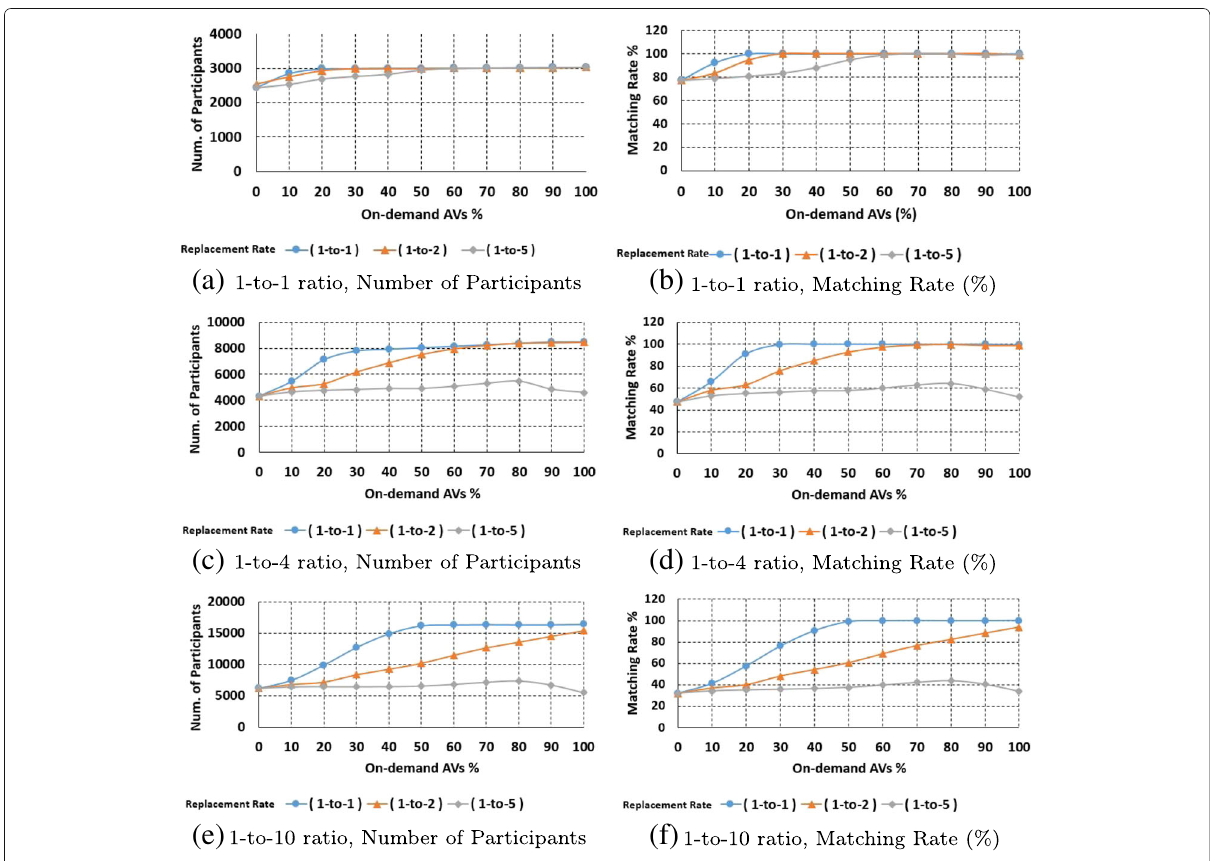
Fig. 10 Paris - Different owner-to-rider ratios. a 1-to-1 ratio, Number of Participants b 1-to-1 ratio, Matching Rate (%) c 1-to-4 ratio, Number of Participants d 1-to-4 ratio, Matching Rate (%) e 1-to-10 ratio, Number of Participants f 1-to-10 ratio, Matching Rate